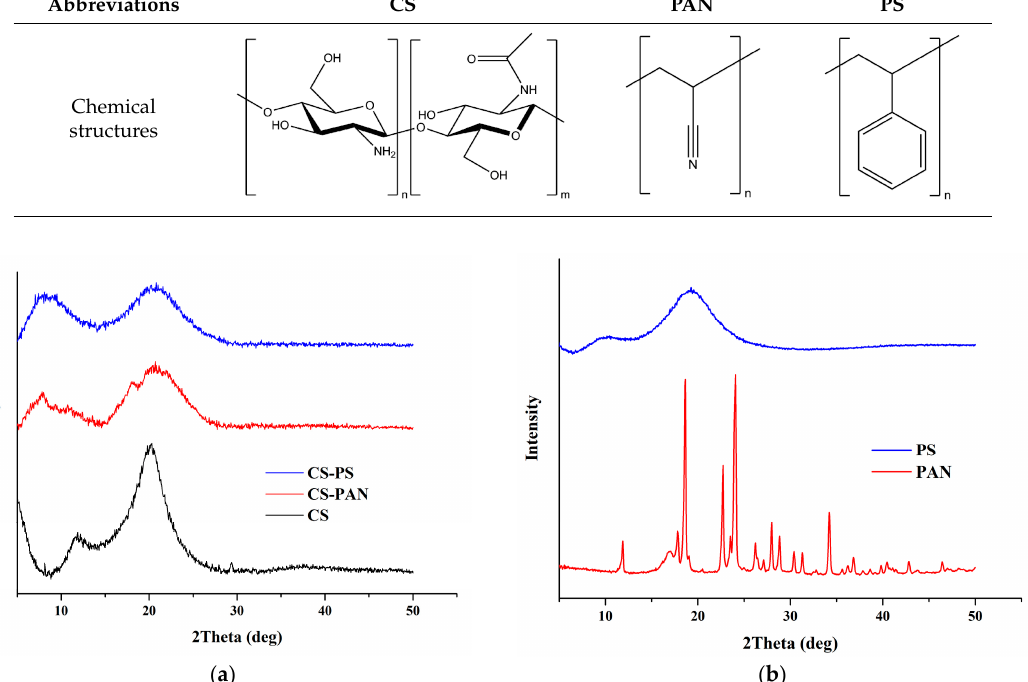
Figure 5. X-ray patterns for ( a ) initial CS, CS-PAN and CS-PS copolymers, ( b ) initial PAN and PS.